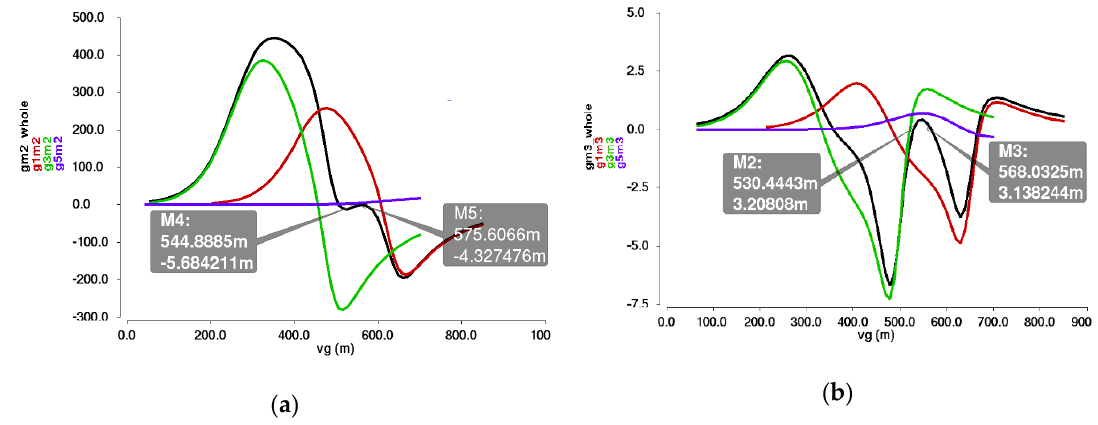
Figure 4. Simulation results of: ( a ) gm2_whole; and ( b ) gm3_whole.